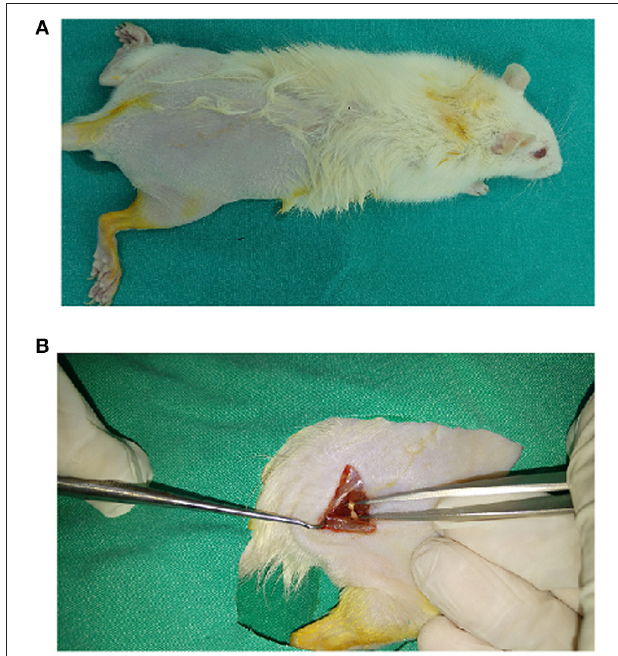
FIGURE 1 | Induction of sciatic nerve injury in right leg of the rats. After anesthesia (A) , the common sciatic nerve of the right hind paw was exposed the middle of thigh by blunt dissection through the biceps femoris (B) . For sciatic nerve crush, a hemostatic sterile clamp was used. The sciatic nerve was crushed for a total of 30s. Then, the wound was closed with a 2.0 suture and rats were allowed to recover in the postoperative room. In sham-operated rats, the same surgical procedure was followed, the connective tissue was freed, and no ligatures were